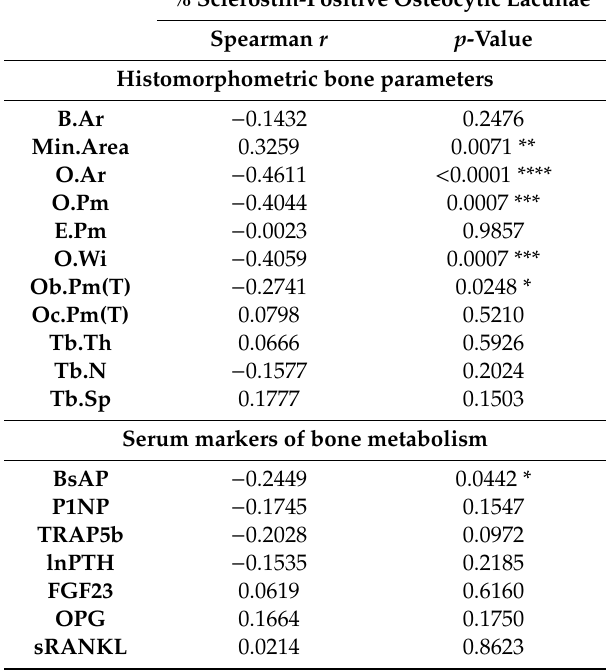
Table 2. Spearman correlation matrix of skeletal sclerostin expression vs. histomorphometric bone parameters and serum markers of bone metabolism.